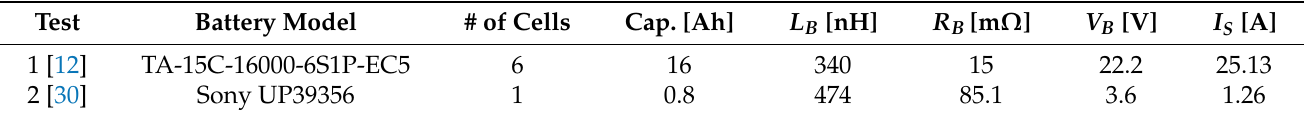
Table 2. Battery electrical parameters used in the circuit simulations.